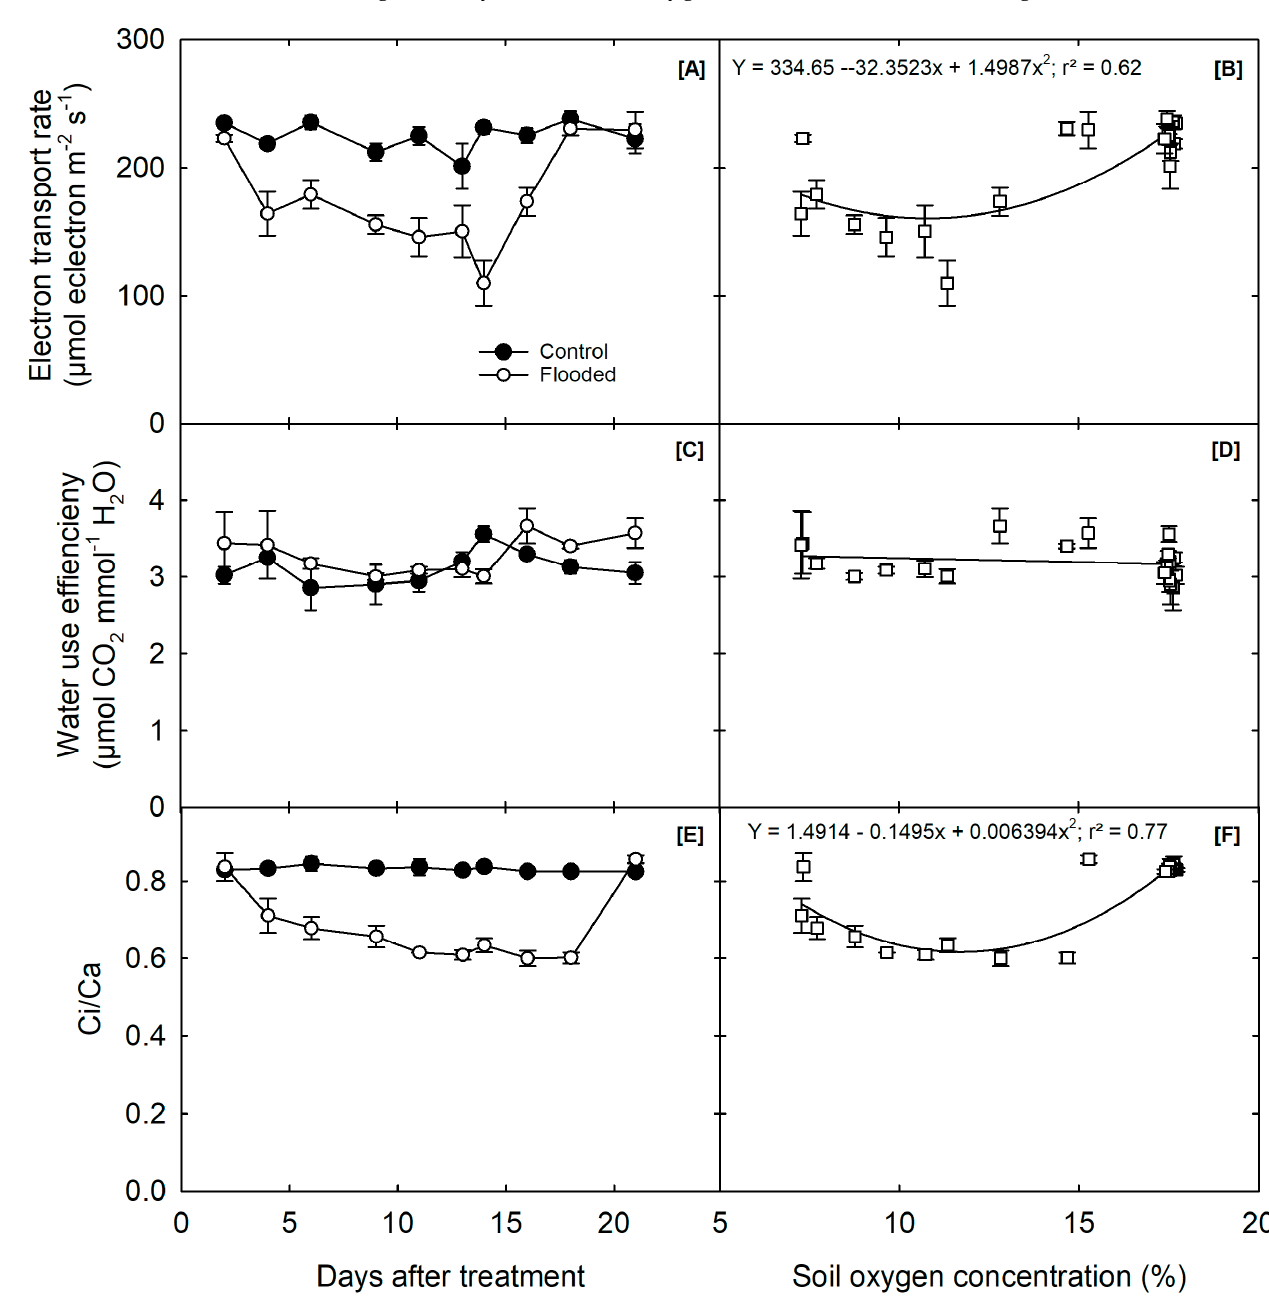
Figure 3. Influence of waterlogging on soybean plants: ( A ) electron transport rate (ETR), ( C ) water use efficiency (WUE), ( E ) ratio of internal and external CO 2 concentration (C i /C a ) measured during the waterlogging treatment, and ( B ) photosynthesis, ( D ) water use efficiency, and ( F ) ratio of internal and external CO 2 concentration (C i /C a ) expressed as a function of soil oxygen concentration using both the treatments data. Each value is the mean of 15 measurements and S.E. ( n = 15). The arrow indicates the day fl ood treatment stopped, and the recovery period started.